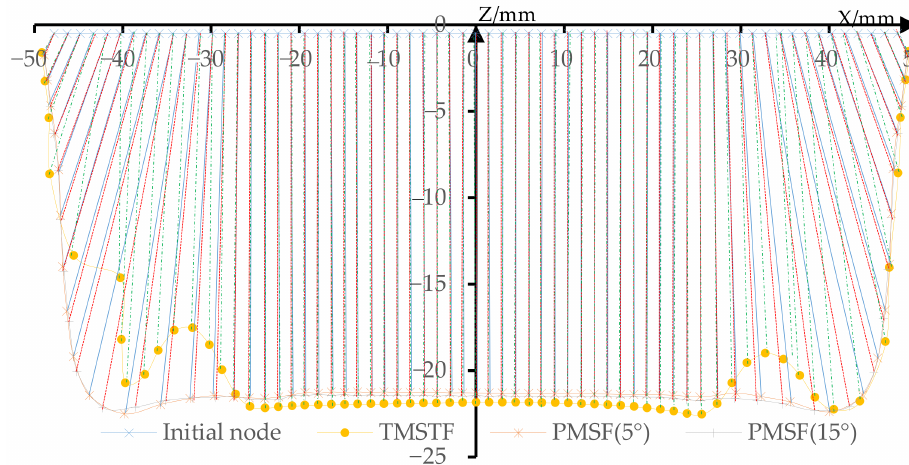
Figure 15. The material flow.